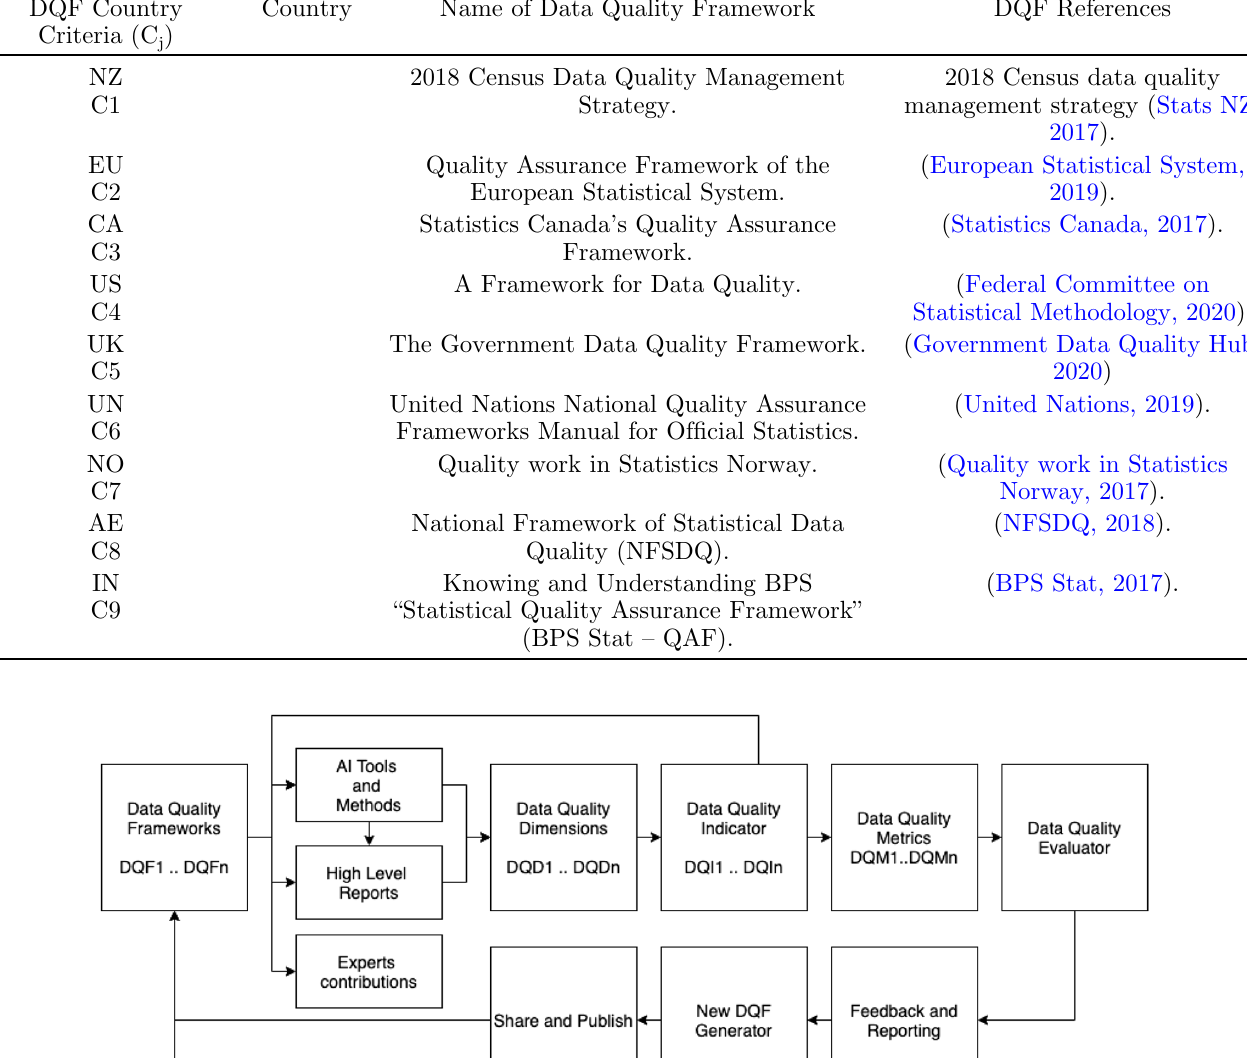
Table 3. Overview of data quality frameworks collected from the NSOs for top-scored countries according to the 2020 UN SDG report.